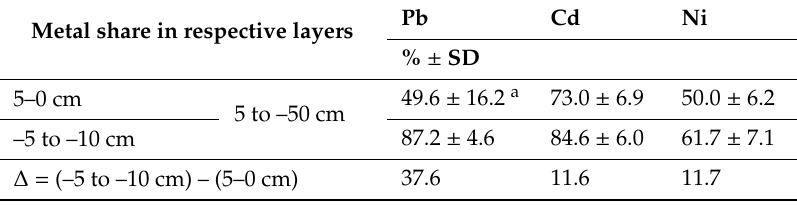
Table 9. Percentage share of Pb, Cd, and Ni in the 5–0 and 5–10 cm layers of the whole (5 to –50 cm) sampling